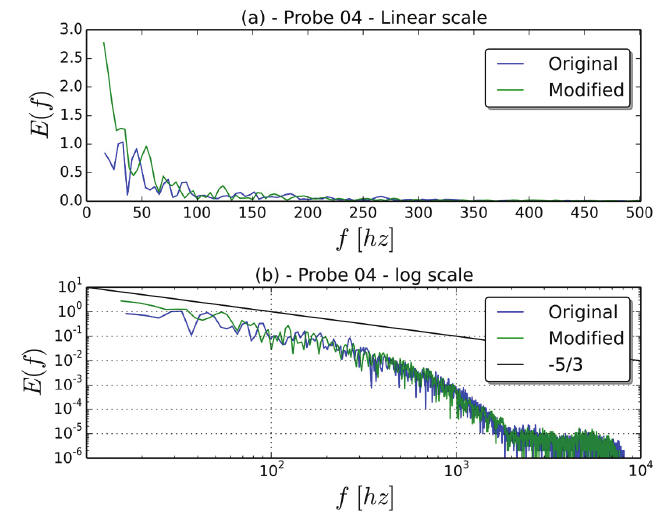
Figure 36 - Energy spectra for probe 4; (a) : in linear scale; (b) : log